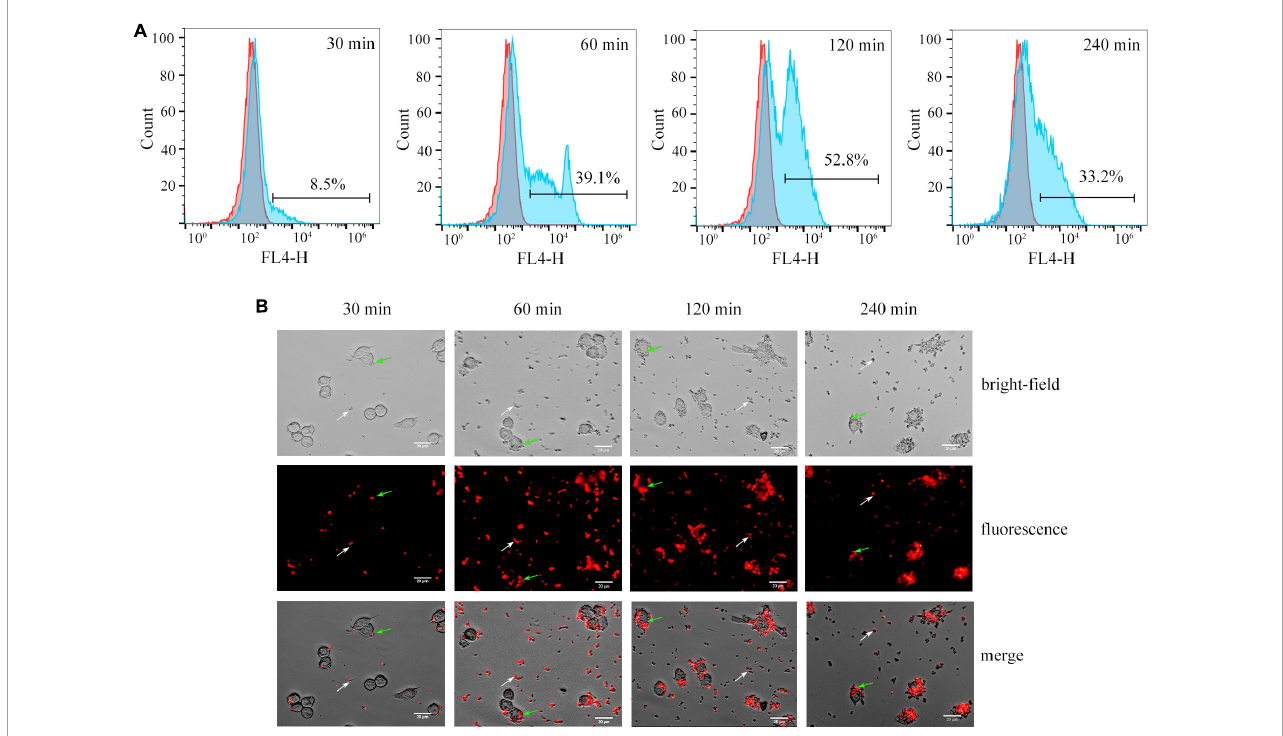
FIGURE6 (A) Flow cytometry analysis showing the phagocytosis of Cy5.5@S. aureus by RAW264.7 macrophages at different times of co-culture in vitro . Representative examples of normal cells (red area), and cells that phagocytosed Cy5.5@S. aureus (blue area) are shown. (B) Fluorescence micrographs of Cy5.5@S. aureus –infected RAW264.7 cells at different time points. The white arrow indicates Staphylococcus aureus outside the macrophages and the green arrow indicates S. aureus that have been phagocytosed by the macrophages (scale bar: 20 µ m, exposure time: 300 ms).